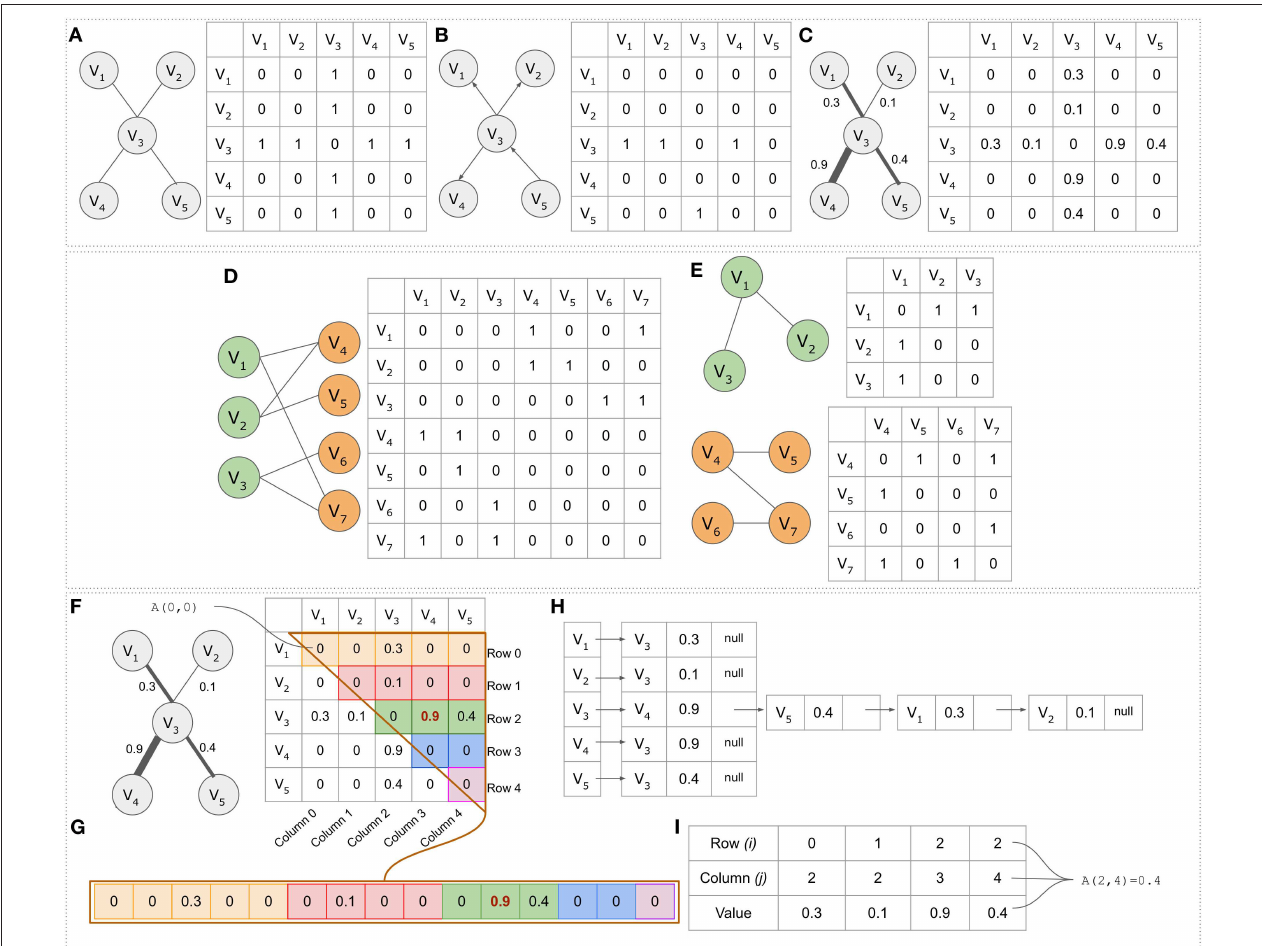
FIGURE 2 | Adjacency matrices and alternative data structures. (A) Simple undirected graph consisting of five nodes ( N = V = 5) and four edges ( E = 4). (B) A directed graph represented by a non-symmetric adjacency matrix. (C) A simple weighted graph. (D) The bipartite graph and its adjacency matrix. (E) The graph’s projections. In the projected network colored as green, node V 1 for example is connected to node V 2 through node node V 4 . (F) The upper triangular part of the adjacency matrix. (G) The upper triangular part of the adjacency matrix in a linear form. Element A[2,3] = 0.9 in the adjacency matrix is element B[10] = 0.9 in the linear form. (H) The graph presented as an adjacency list. Each vertex is accompanied by a list containing all other vertices adjacent to it. (I) A data structure for efficiently storing sparse matrices with many zeros. The first two rows indicate the coordinates in an adjacency matrix, whereas the third column contains the connection weight.